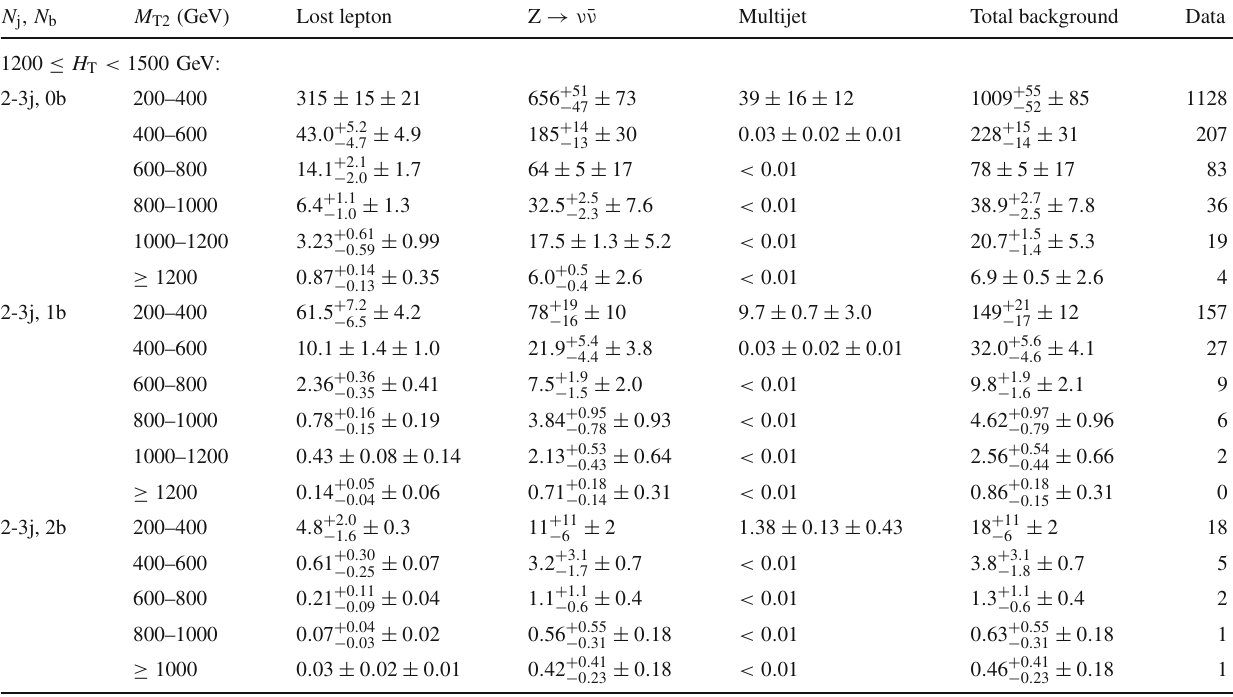
Table 19 Predictions and observations for the 17 search regions with 1200 ≤ H T < 1500 GeV and 2 ≤ N j ≤ 3. For each of the background predictions, the first uncertainty listed is statistical (from the limited